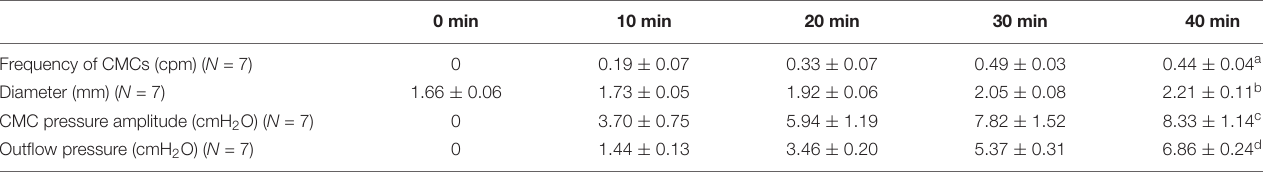
TABLE 1 | The effect of increasing distention induced by outflow pressure on CMC frequency and diameter of the colon.